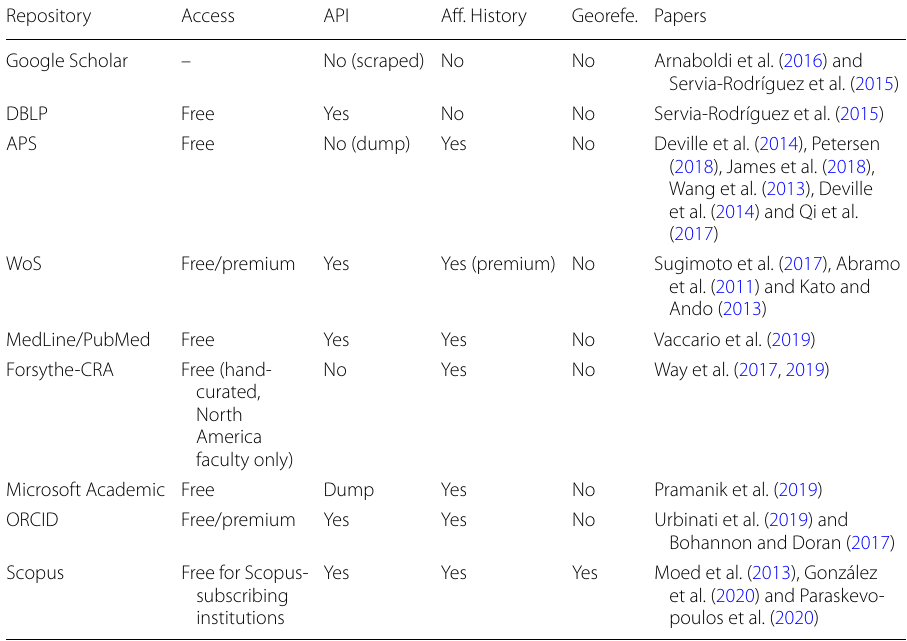
Table 1 Summary of academic knowledge/career repositories